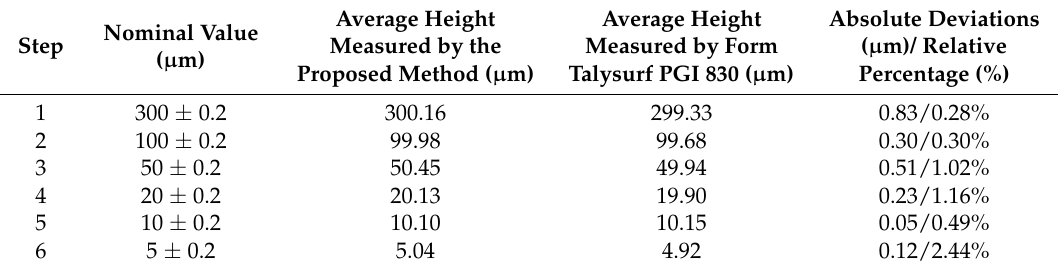
Table 3. The average heights measured by the proposed method and Form Talysurf PGI 830 together with the relative errors.